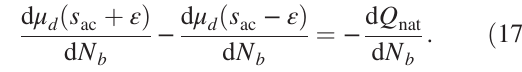
FIG. 4. Driven horizontal phase advance beating versus inten- sity calculated with HEADTAIL simulations of a broadband impedance placed close to the IP7 in the LHC at 20 km. An ac dipole is used as